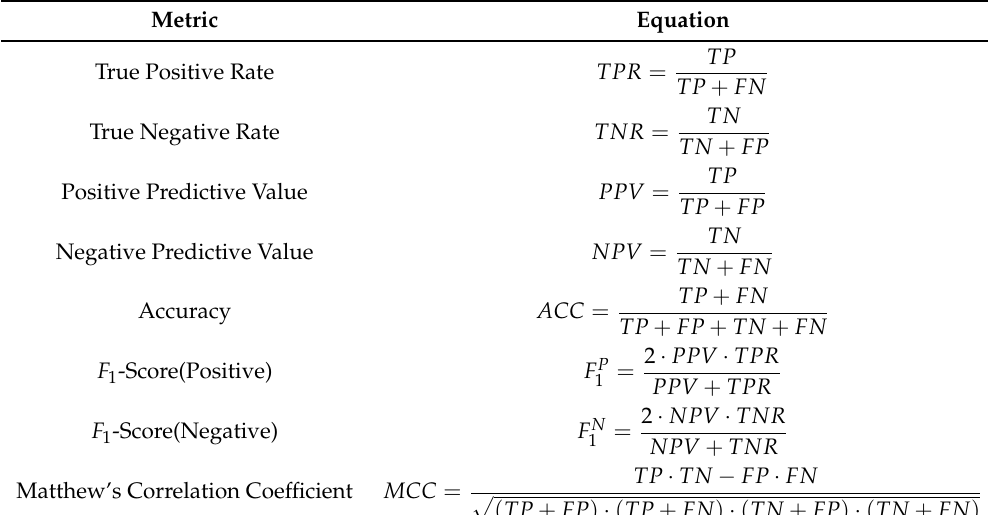
Table 3. Evaluation metrics adopted during the relevance feedback